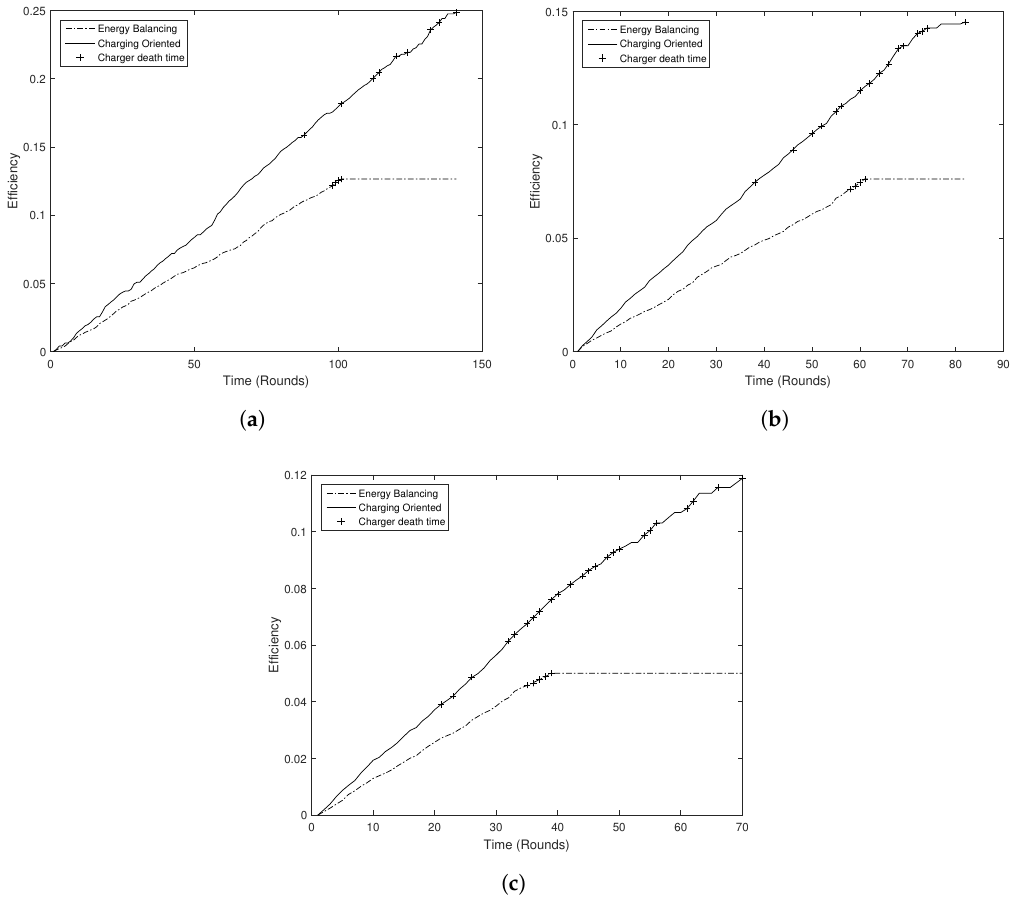
Figure 5. Cumulative charging efficiency over time for ( a ) 10, ( b ) 20 and ( c ) 30 chargers